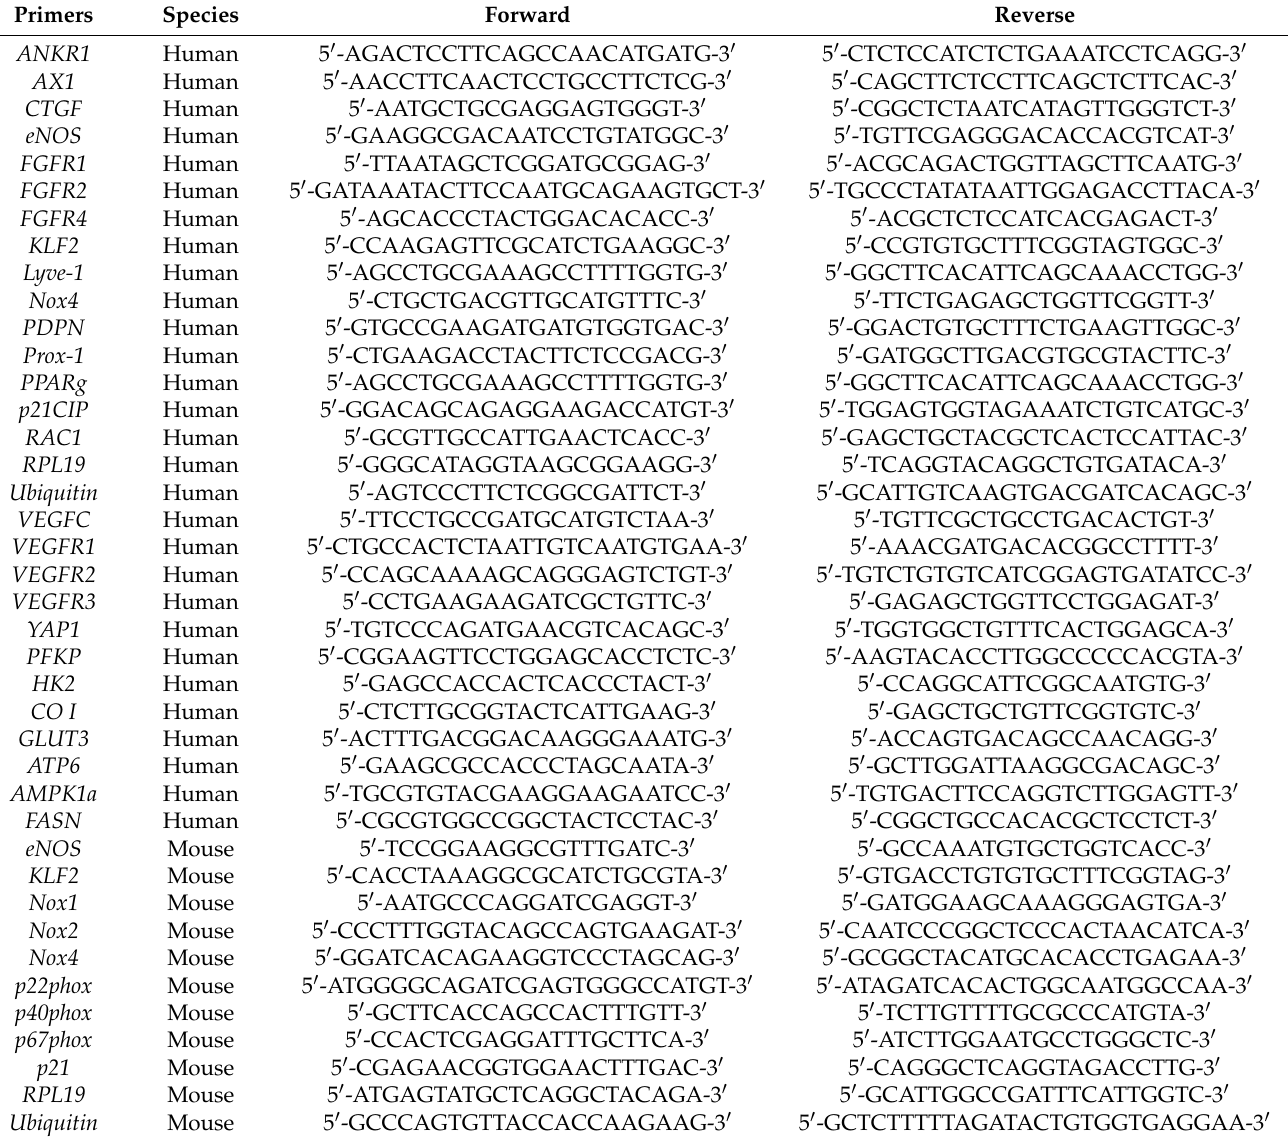
Table 1. Primers used in